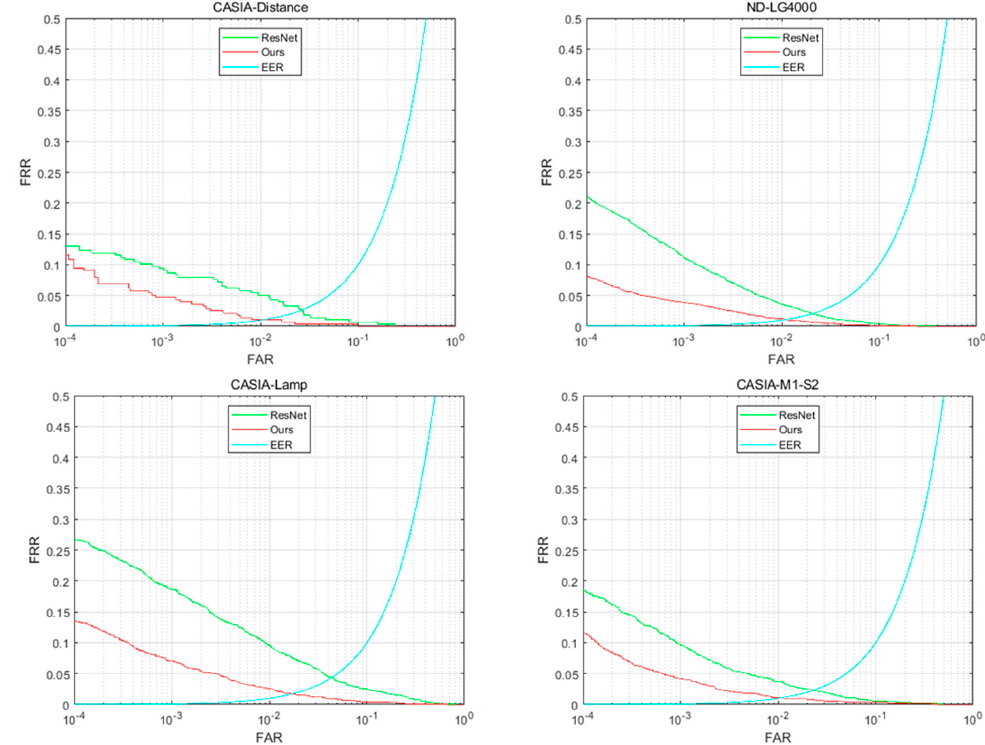
Figure 6. DET curves obtained from iris verification experiments conducted using ResNet and the proposed method.